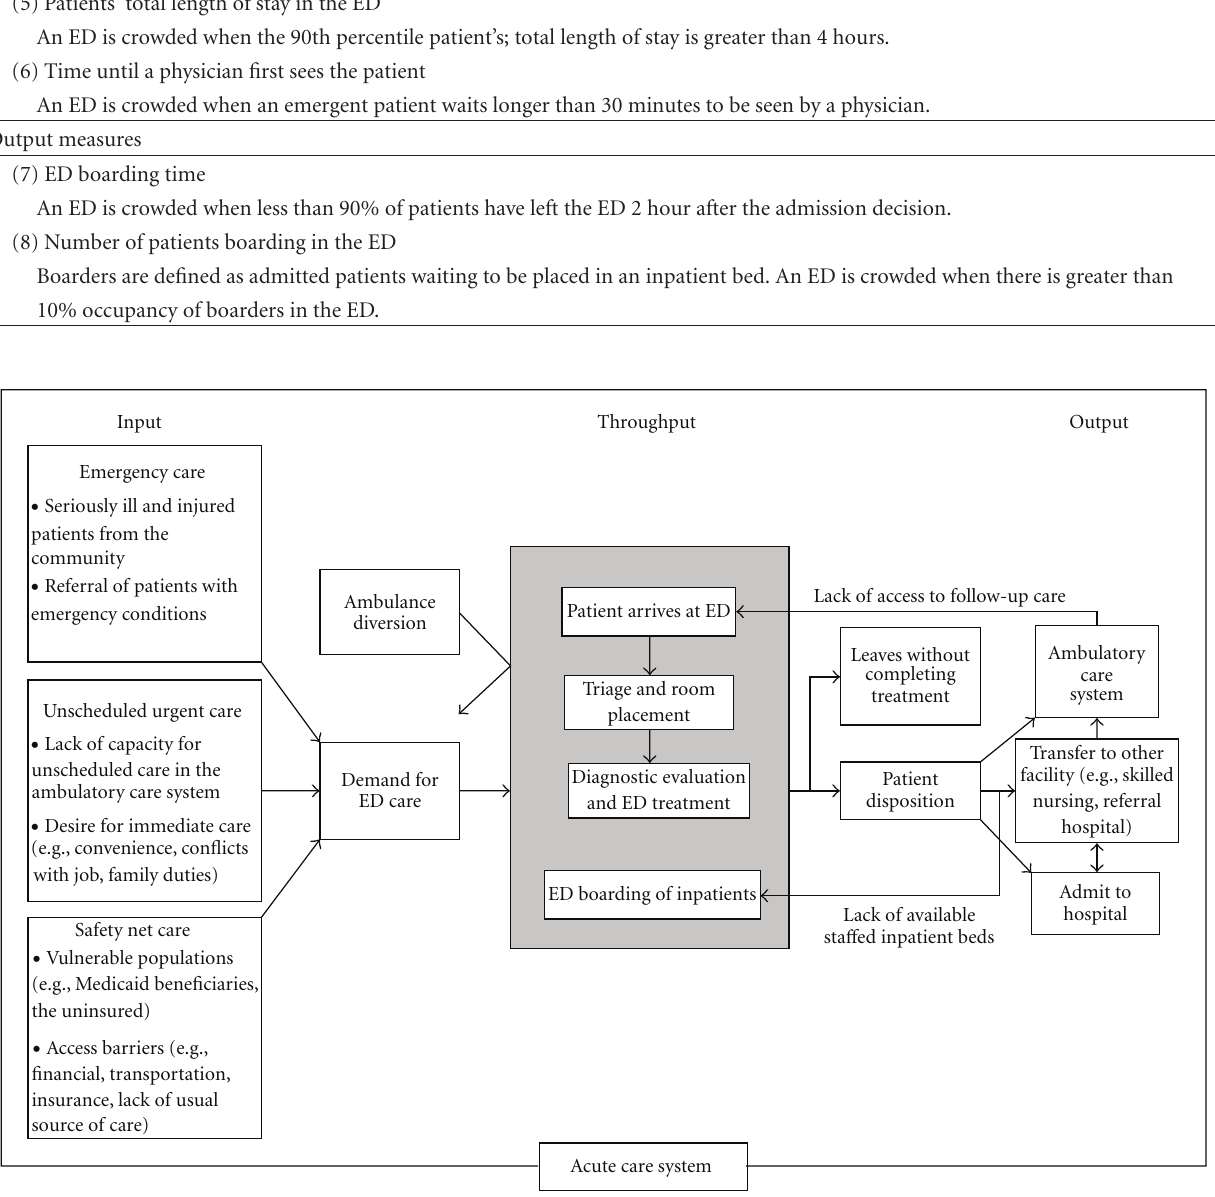
Figure 1: Asplin’s model of acute